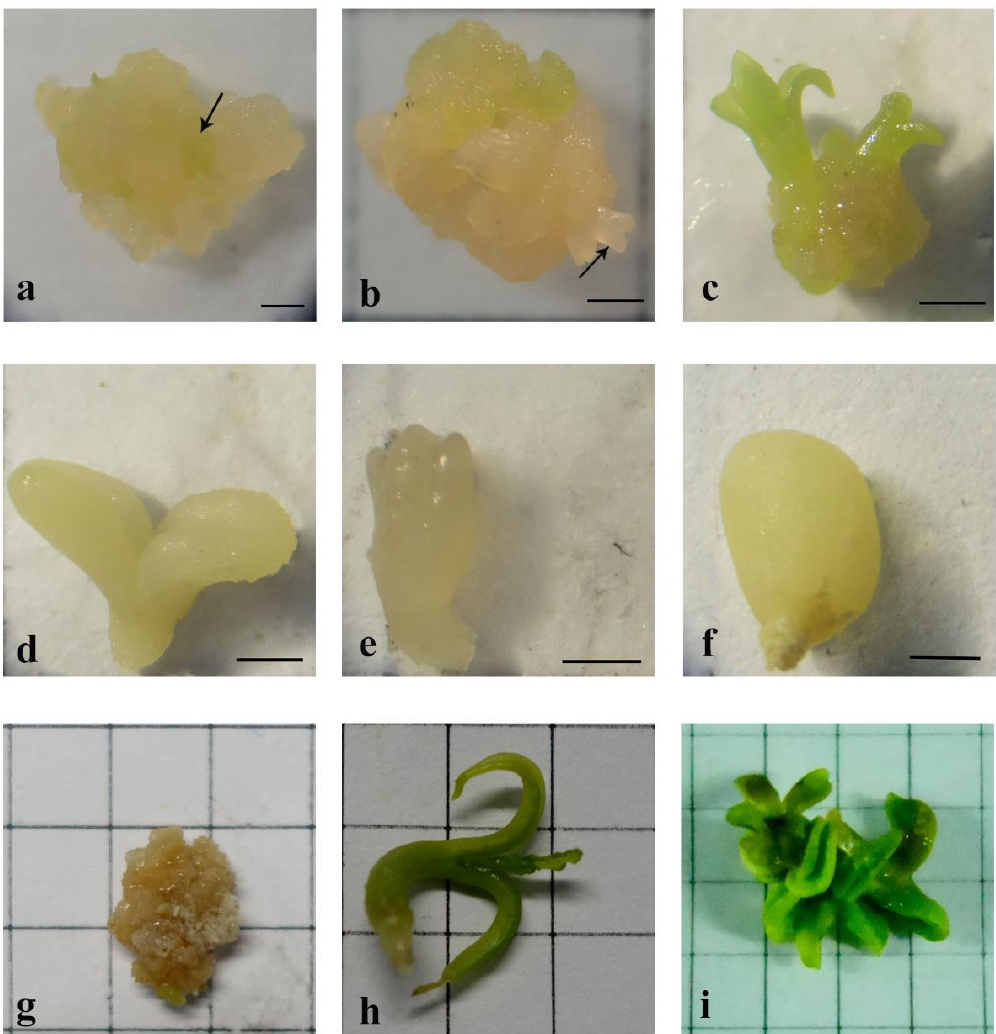
Figure 2. Characterization of in vitro morphogenic responses of K. paniculata embryogenic calluses. ( a ) Embryogenic callus with smooth surfaces, green embellishments (arrow in a ) and nodular protrusions. ( b – c ) Cotyledon embryo (arrow in b ) derived via embryogenic callus. ( d ) Normal cotyledon embryo. ( e ) Fused cotyledon embryo. ( f ) Monocotyledonous embryo. ( g ) Sub-cultured embryogenic callus. ( h ) Mature cotyledon embryo. ( i ) Mature fused cotyledon embryo. Bars in a – f represent 0.2 cm. Size of squares in g – i are 1 cm × 1 cm.